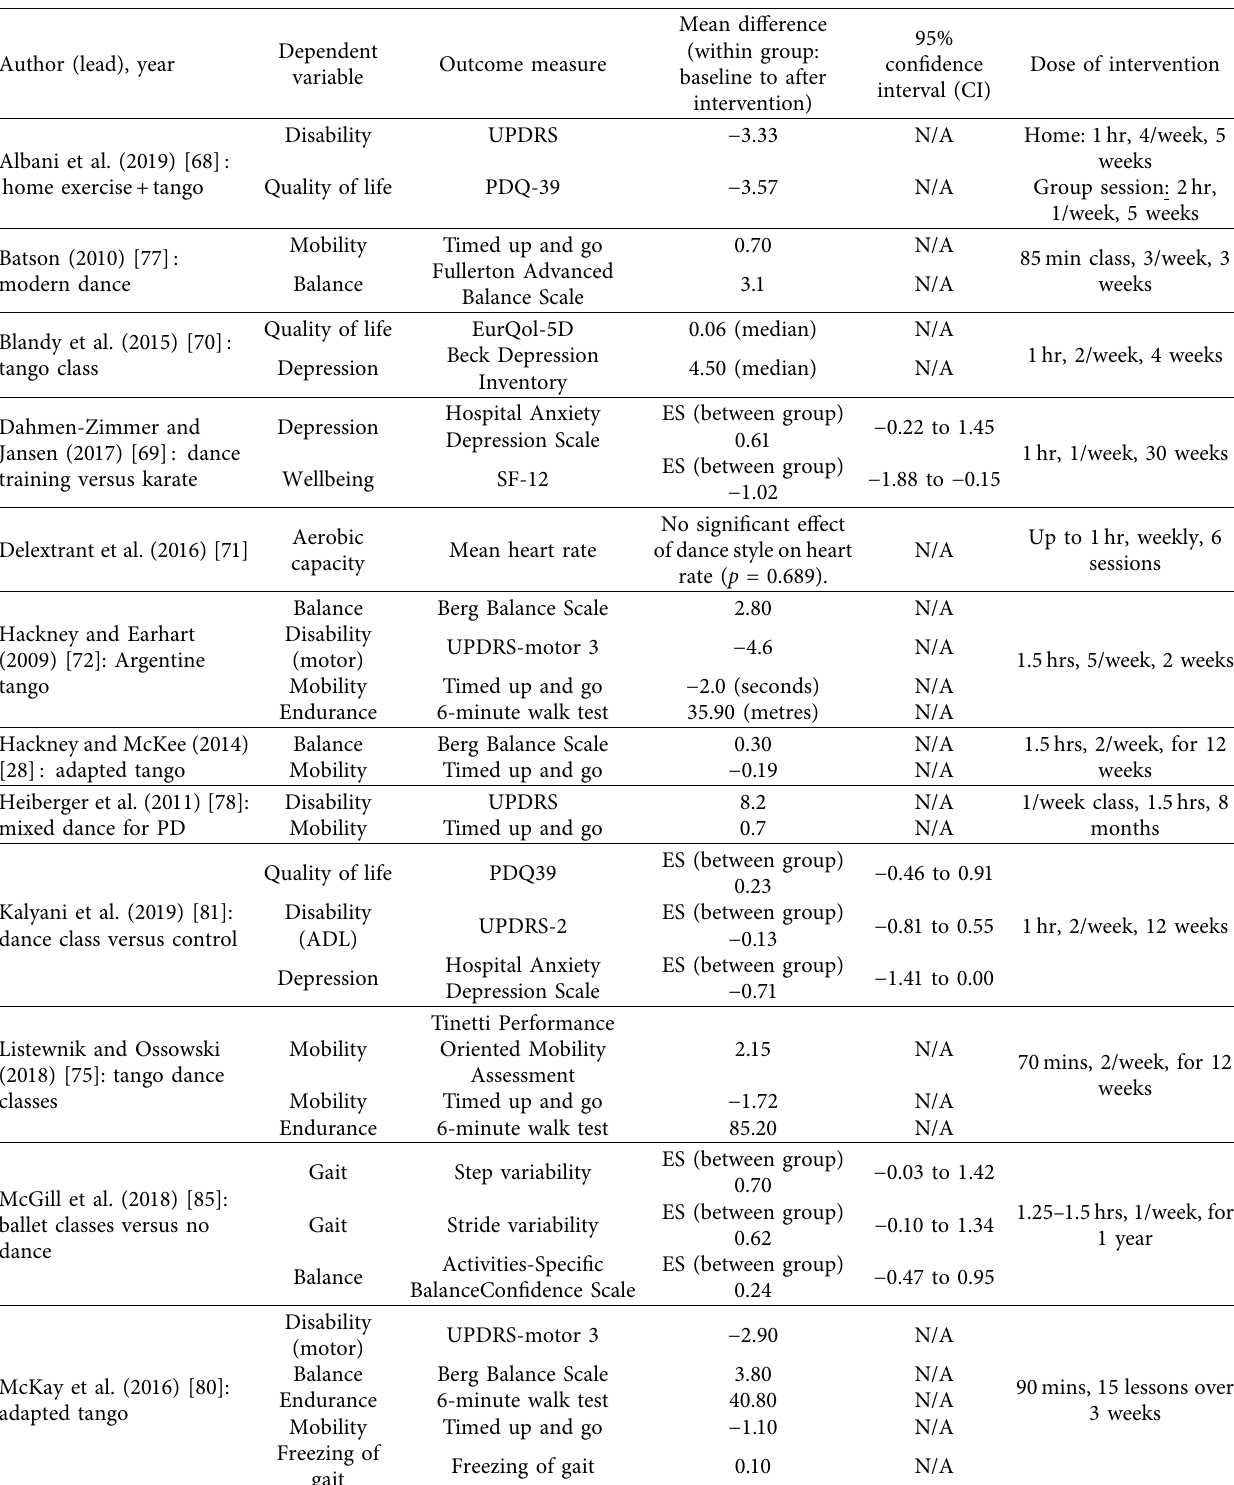
Table 5: Data analysis for nonrandomised